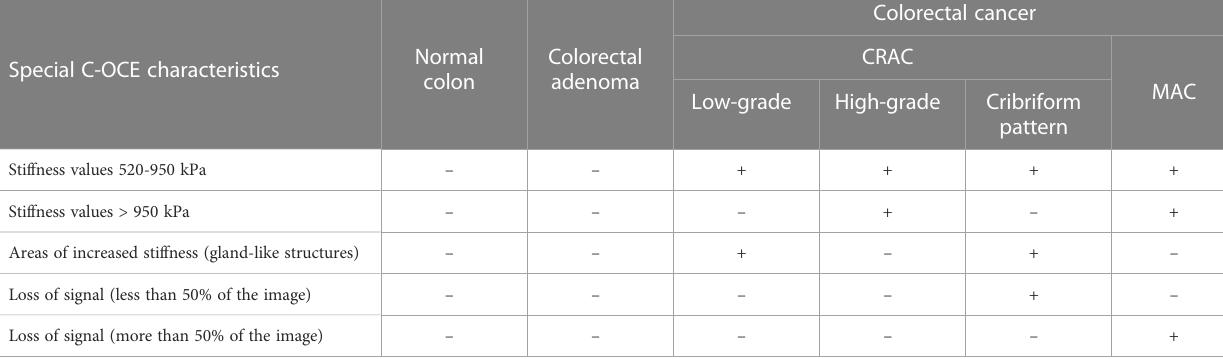
TABLE 2 A summary table of C-OCE characteristic features of normal colon, colorectal adenoma and each colorectal cancer morphological subtype.